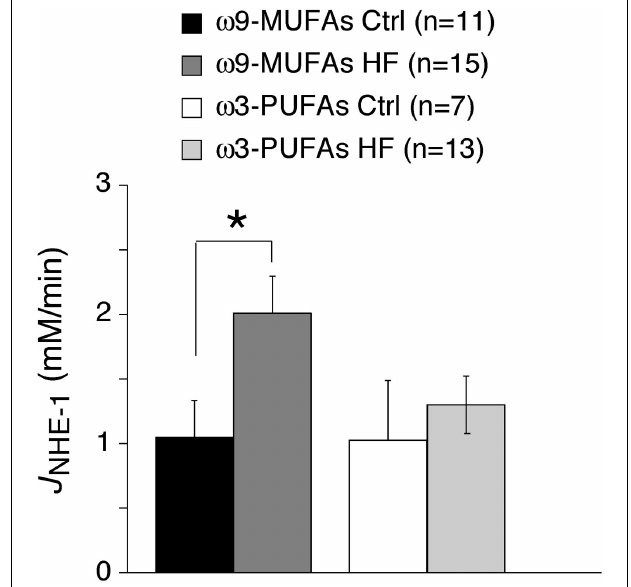
FIGURE 4 |Average J NHE-1 at pH = 7.0 of healthy (Ctrl) and HF rabbits fed ω 9-MUFA and ω 3-PUFA rich diets. Note that J model in ω 9-MUFA fed animals, while it was not changed in ω 3-PUFA animals. * P < 0.05.